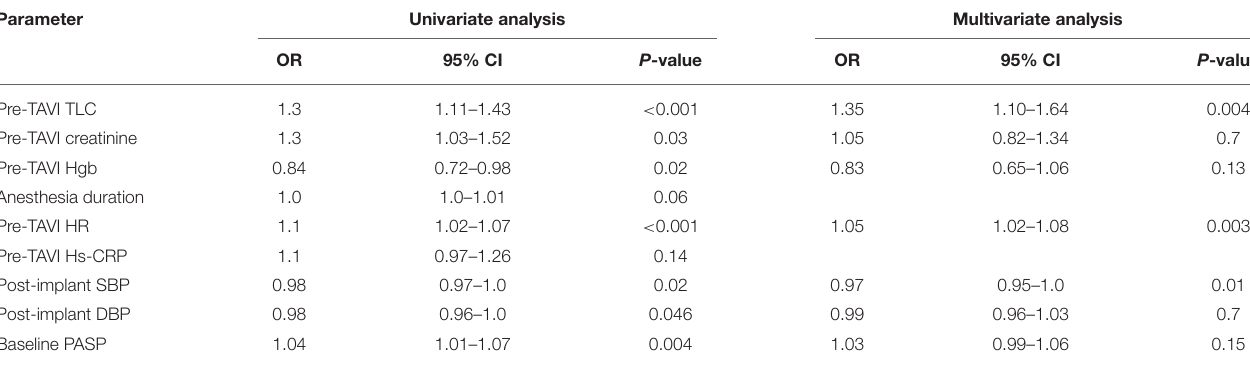
TABLE 6 | Logistic regression analysis for prediction of SIRS.